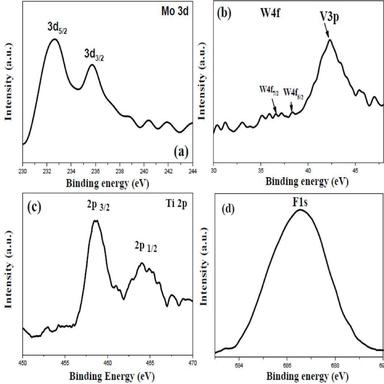
The typical, illustrative, curve fitted core level spectra of (a) Mo 3d, (b) W 4f, (c) Ti 2p and (d) F1s in the as deposited thin films on the Al6061 substrates.